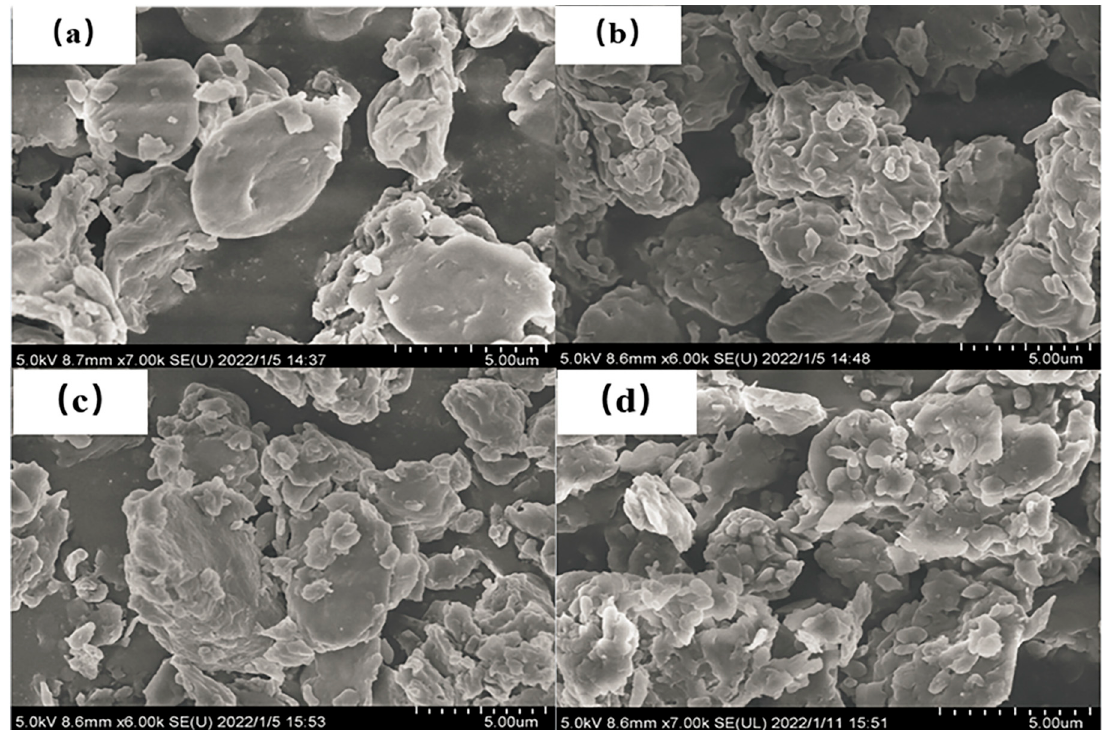
Figure 4. SEM images of microalgae before ( a ) and after treatment by PVC ( b ), PP ( c ), and PET ( d ) MPs.